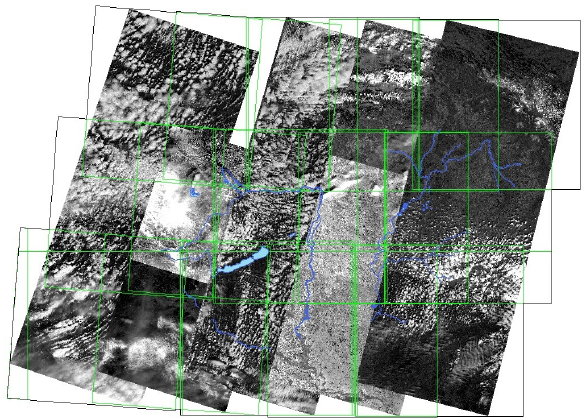
Figure 3: Bounding boxes of Landsat 8 images (band 4) of Hun- gary